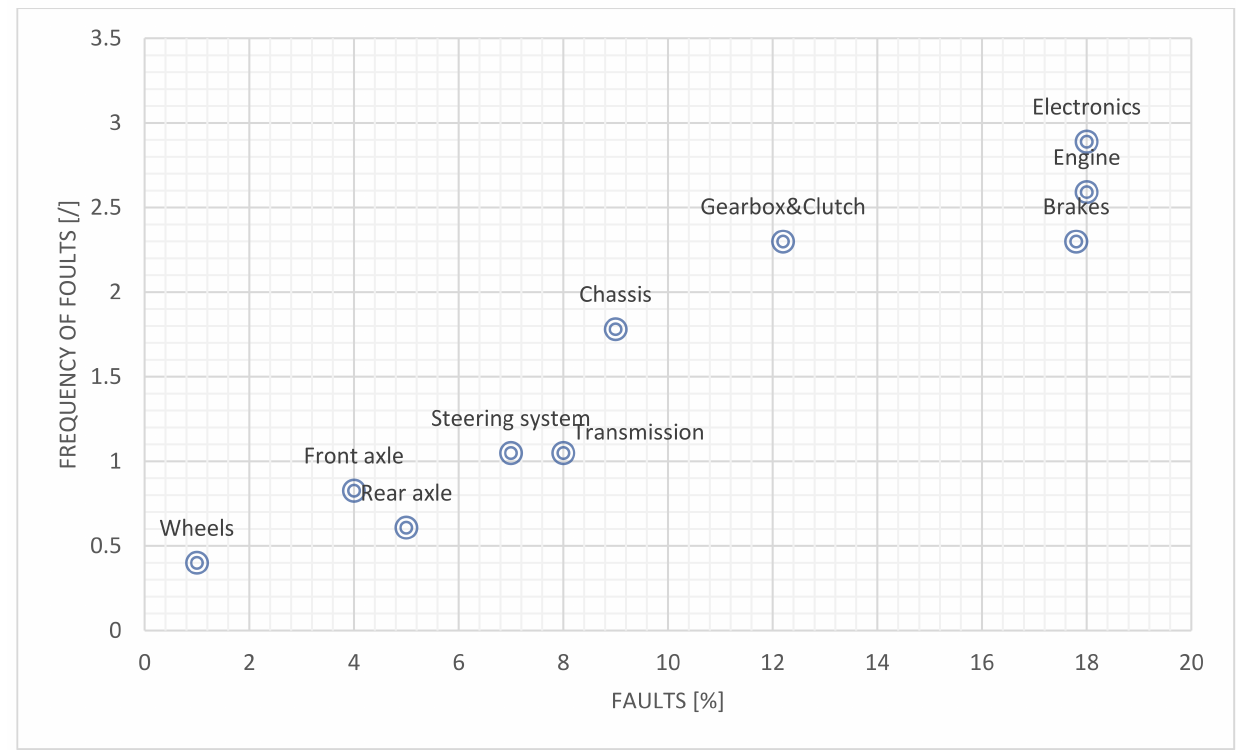
Figure 1. Distribution and frequency of